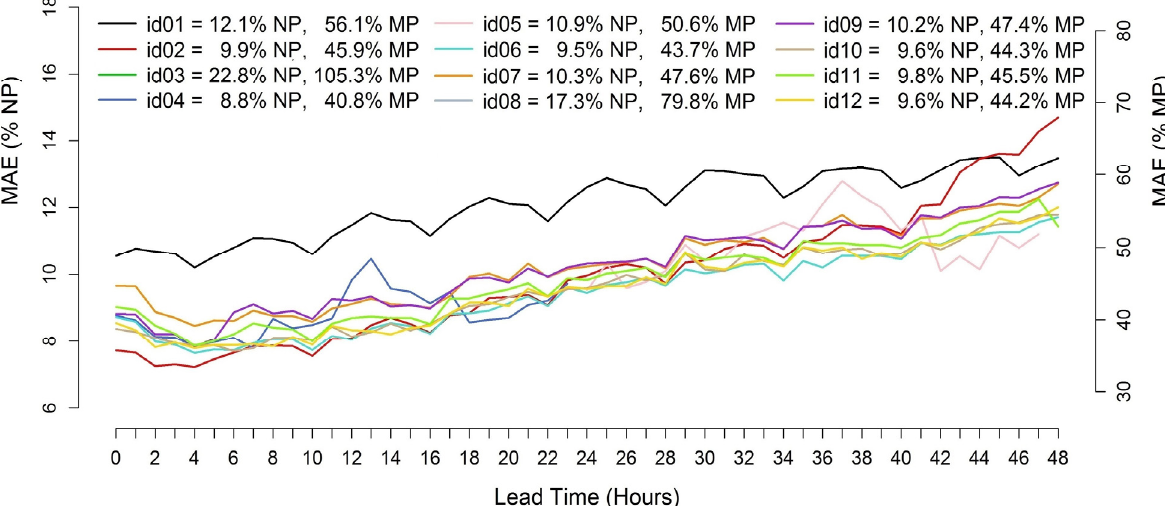
Figure 3. Error trends of the 0–48 h ahead wind power forecasts starting at 0, 6, 12 and 18 UTC for the Klim test case ( MAE / NP % and MAE / MP %).